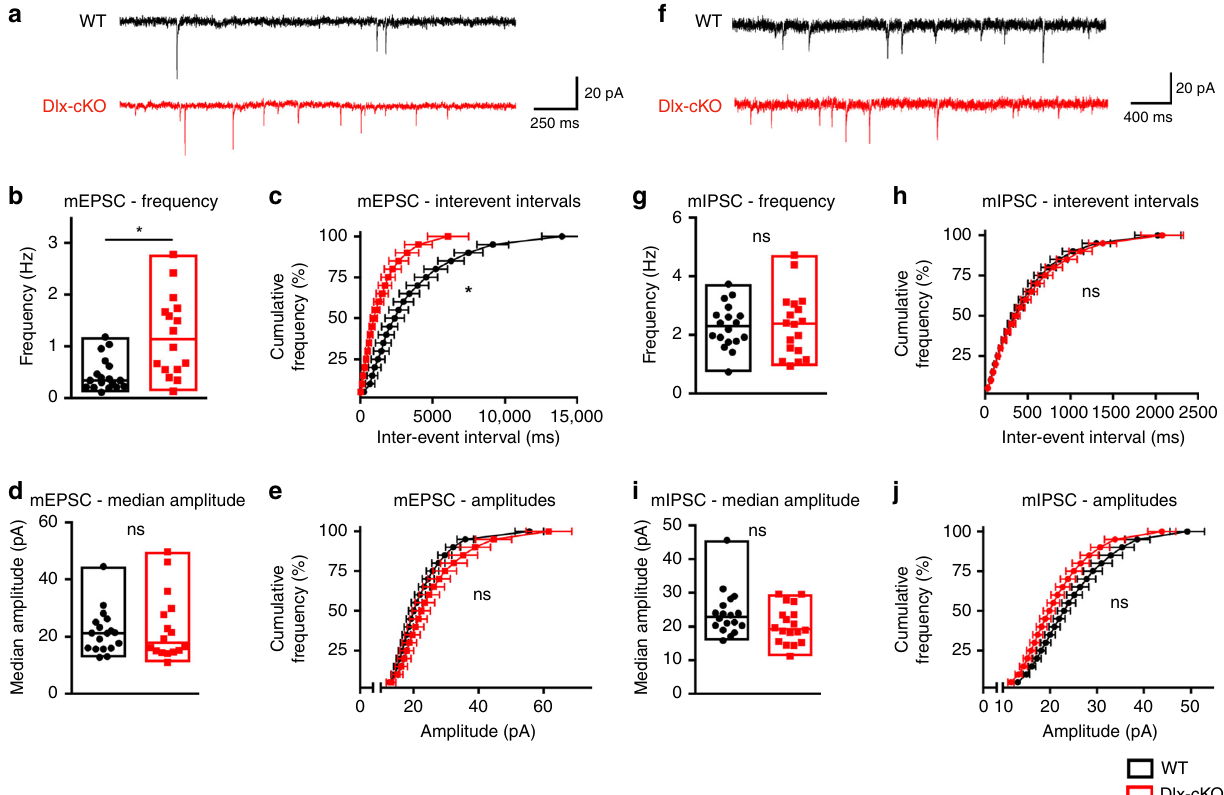
Fig. 3 Enhanced excitatory synaptic transmission but unaltered inhibitory synaptic transmission in Dlx-cKO mice. a Representative mEPSC traces for cells from WT and Dlx-cKO mice. b Dlx-cKO mice show signi fi cantly enhanced mEPSC frequency at CA1 pyramidal neurons (linear mixed effect analysis). c The cumulative frequency distribution of mEPSC inter-event intervals is also signi fi cantly shifted in Dlx-cKO mice (linear mixed effect analysis with least-square means post-hoc testing). d The mEPSC median amplitude is unaltered in Dlx-cKO mice (linear mixed effect analysis). e The cumulative frequency distributions of mEPSC amplitudes are not signi fi cantly different between Dlx-cKO and WT mice (linear mixed effect analysis). f Representative mIPSC traces for cells from WT and Dlx-cKO mice. g Dlx-cKO mice show unaltered mIPSC frequency at CA1 pyramidal neurons (linear mixed effect analysis). h The cumulative frequency distributions of mIPSC inter-event intervals were not signi fi cantly different between Dlx-cKO and WT mice (linear mixed effect analysis). i The median amplitude of mIPSCs is not signi fi cantly different between Dlx-cKO and WT mice (linear mixed effect analysis). j The cumulative frequency distributions of mIPSC amplitudes are not signi fi cantly different between Dlx-cKO and WT mice (linear mixed effect analysis). For mEPSCs: WT, n = 18 cells/3 mice; Dlx-cKO, n = 16 cells/3 mice; for mIPSCs: WT, n = 18 cells/3 mice; Dlx-cKO, n = 18 cells/3 mice. * p < 0.05. Error bars s.e.m. Source data are provided as a Source Data fi